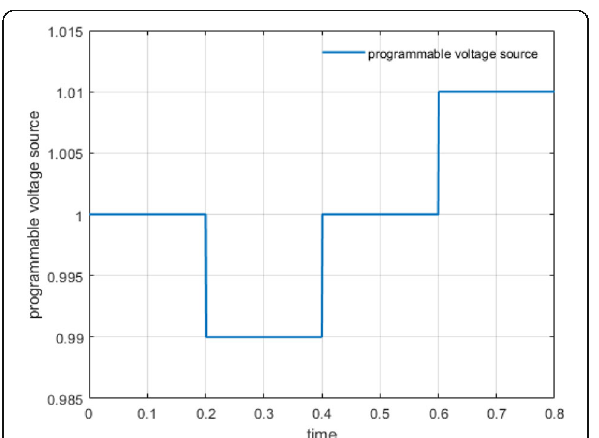
Fig. 2 (Abstract P5). Programmable voltage source at Bus 650 [Slack Bus]